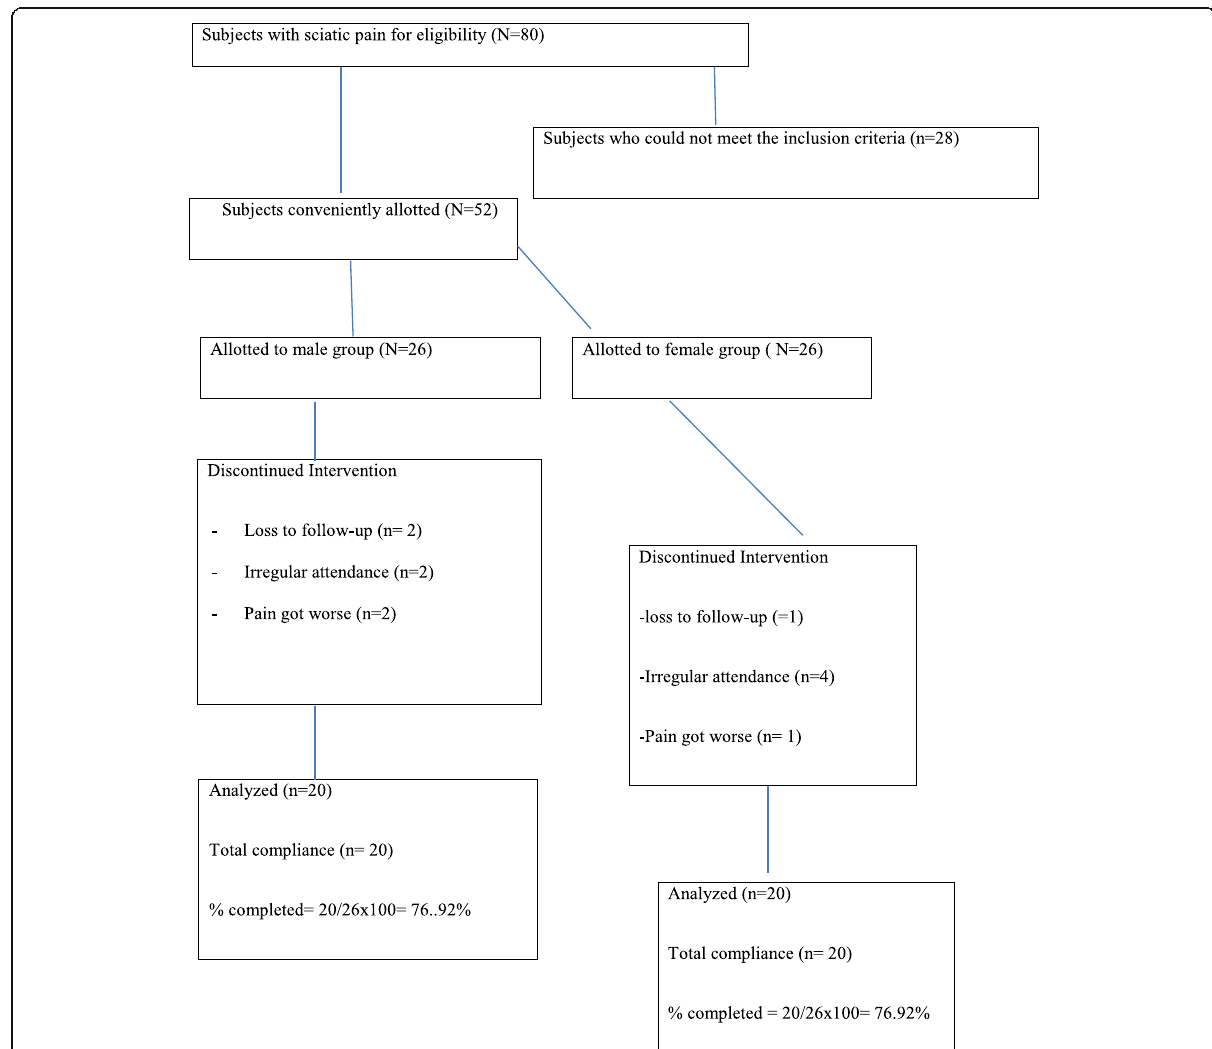
Fig. 1 Recruitment flow diagram. Eighty subjects were recruited; 28 subjects did not meet the inclusion criteria and hence were excluded. Fifty- two subjects met the inclusion criteria and were conveniently allotted to the two groups according to their gender. Twelve subjects, 6 from each group discontinued intervention because of loss to follow-up, irregular attendance, and worsening of pain. Forty subjects, 20 each from